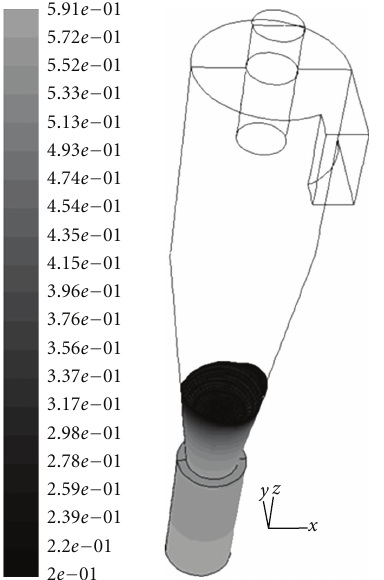
Figure 12: Contours of talc volume fraction (accumulation in the cyclone